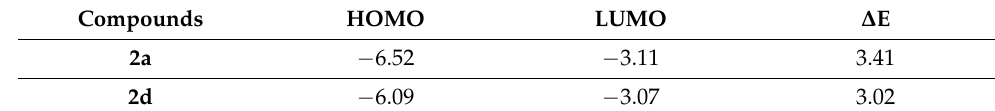
Table 6. FMO Energies e.V. of the prepared compounds 2a and 2d.